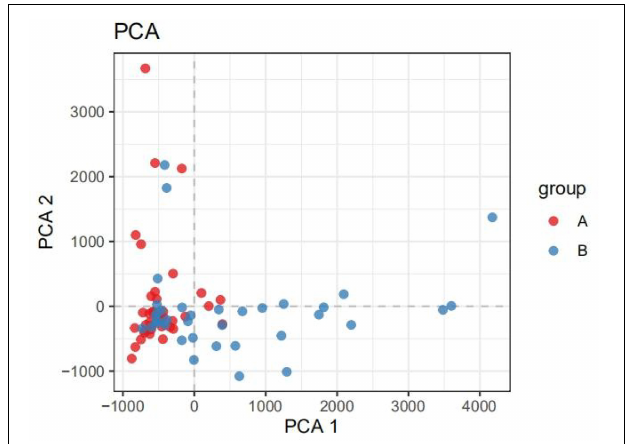
FIGURE 1 | PCA analysis diagram. (Dots of different colors or shapes represent different groups of samples; the closer the two sample points are, the more similar the species composition of the two samples